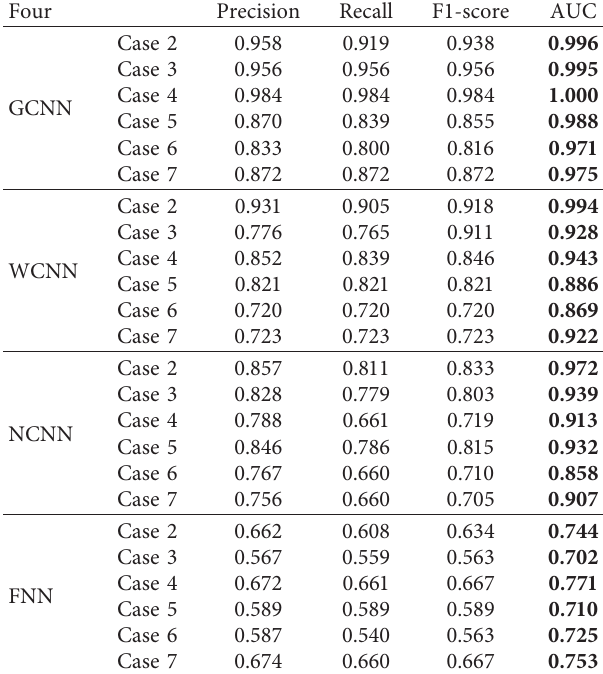
Table 6: Performance of different deep learning methods in four- classes diagnosis.